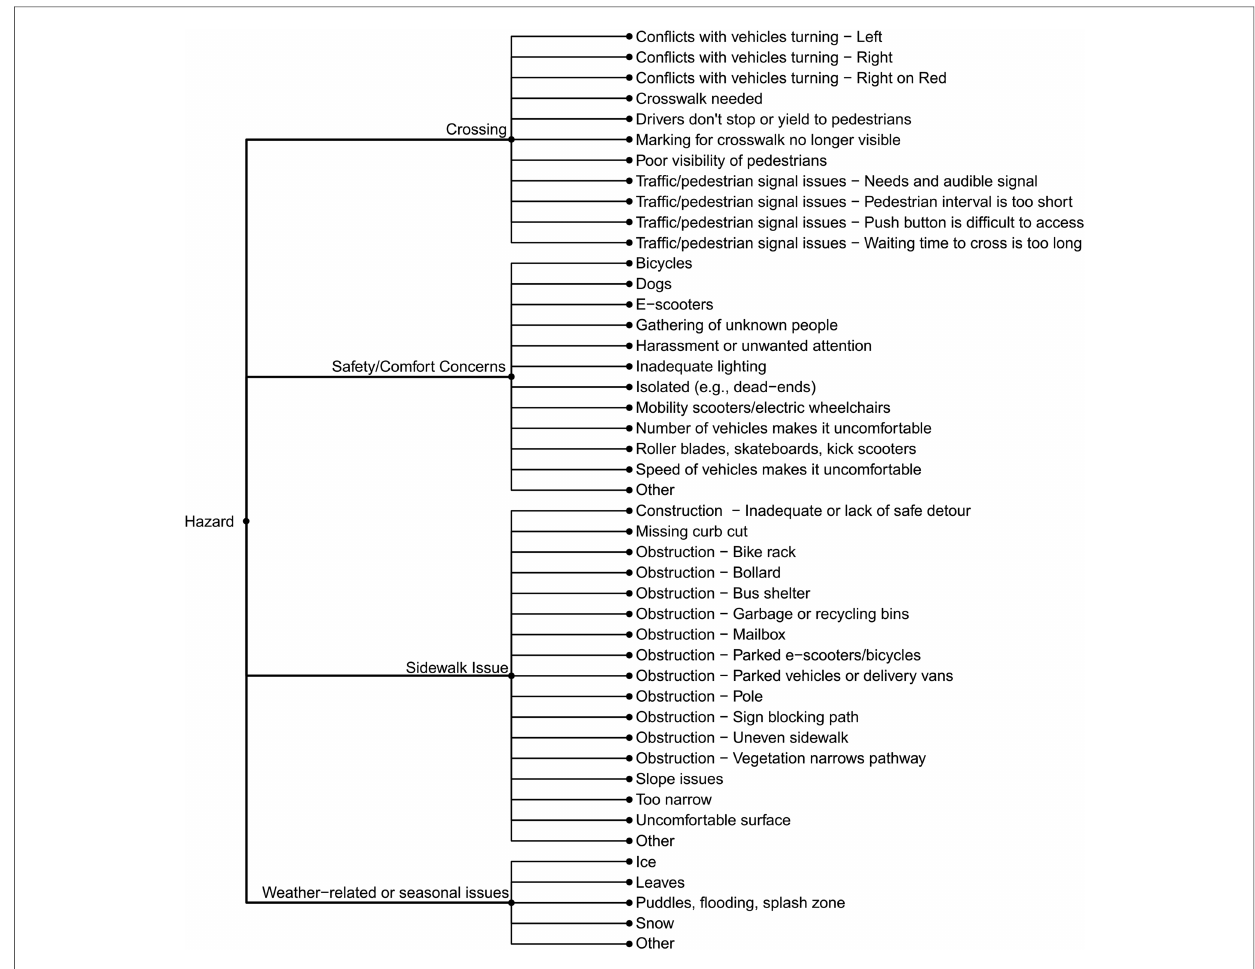
FIGURE 2 Choice of nested responses if participant chooses to map a Hazard or